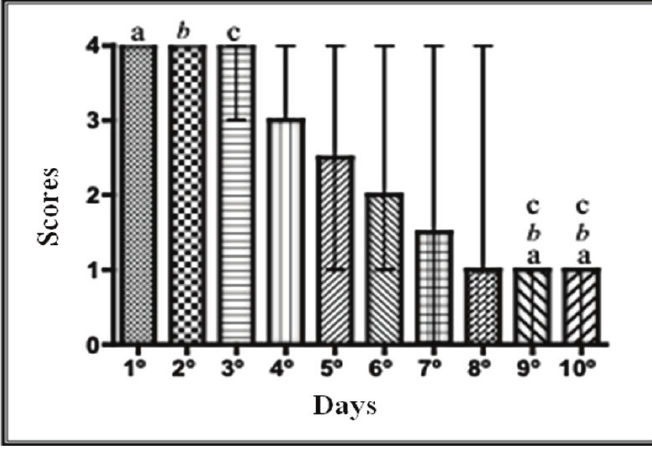
FIGURE 8 - Median and amplitude of the histopathological scores of the animals subjected to traumatic ulceration induction in the cheek mucosa. Comparisons were made by non-parametric Kruskal-Wallis test followed by Dunn post-test (p<0.01). Statistically significant differences were observed among groups at days 1 and 9 (a), 1 and 10 (a), 2 and 9 (b), 2 and 10 (b), 3 and 9 (c), and 3 and 10